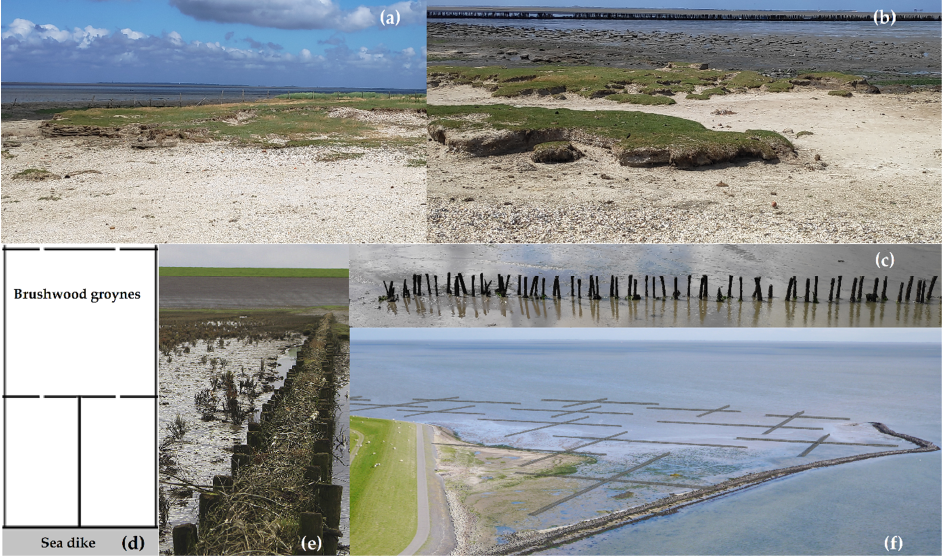
Figure 3. ( a , b ) Ground level view at the study site. The cliff height at the marsh front ranges from